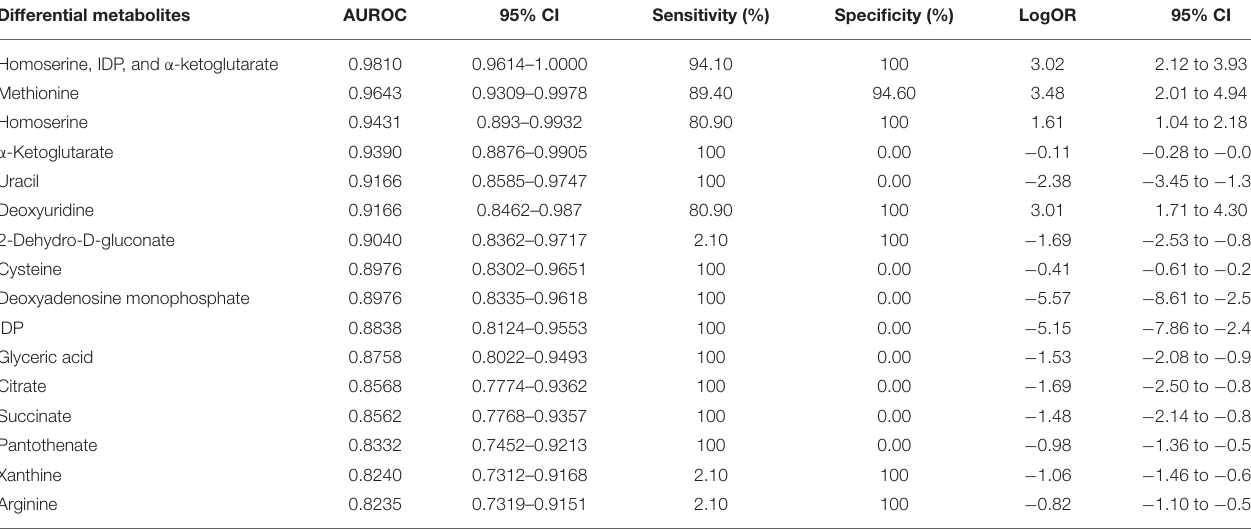
Logarization transformation of the data was applied to the data before the calculation.